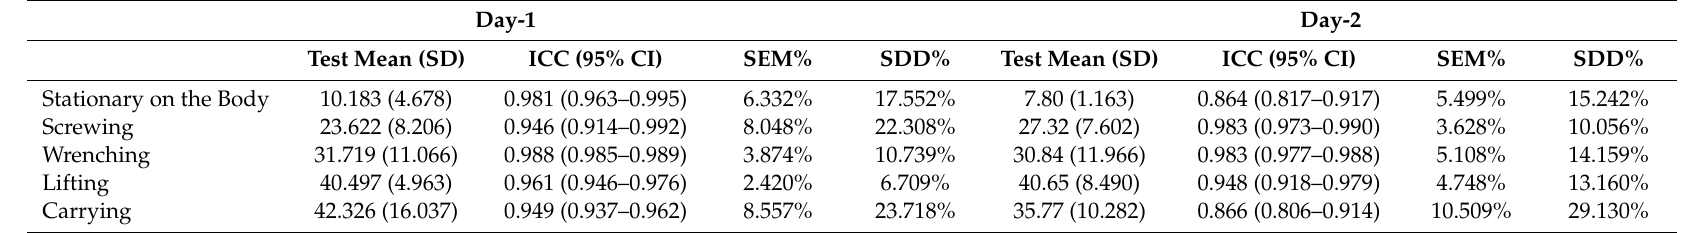
Table 7. EMG trial-to-trial reliability